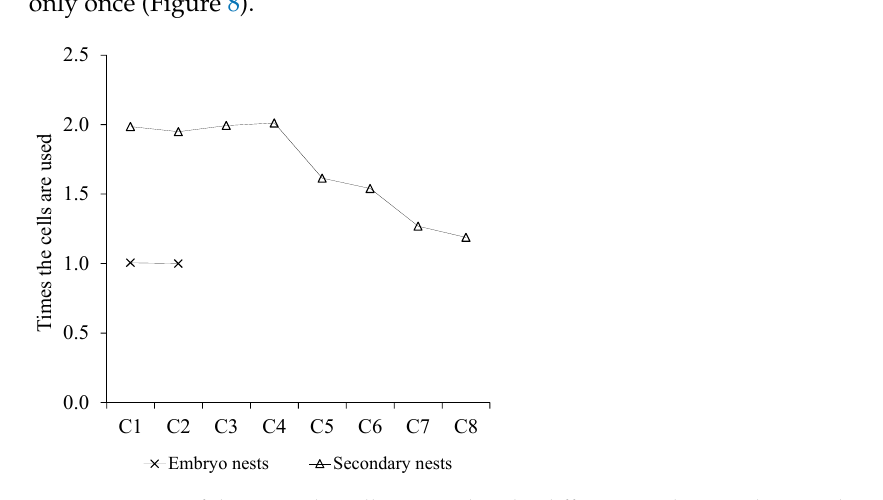
Figure 8. Mean of the times the cells are used in the different combs in embryo and secondary nests.